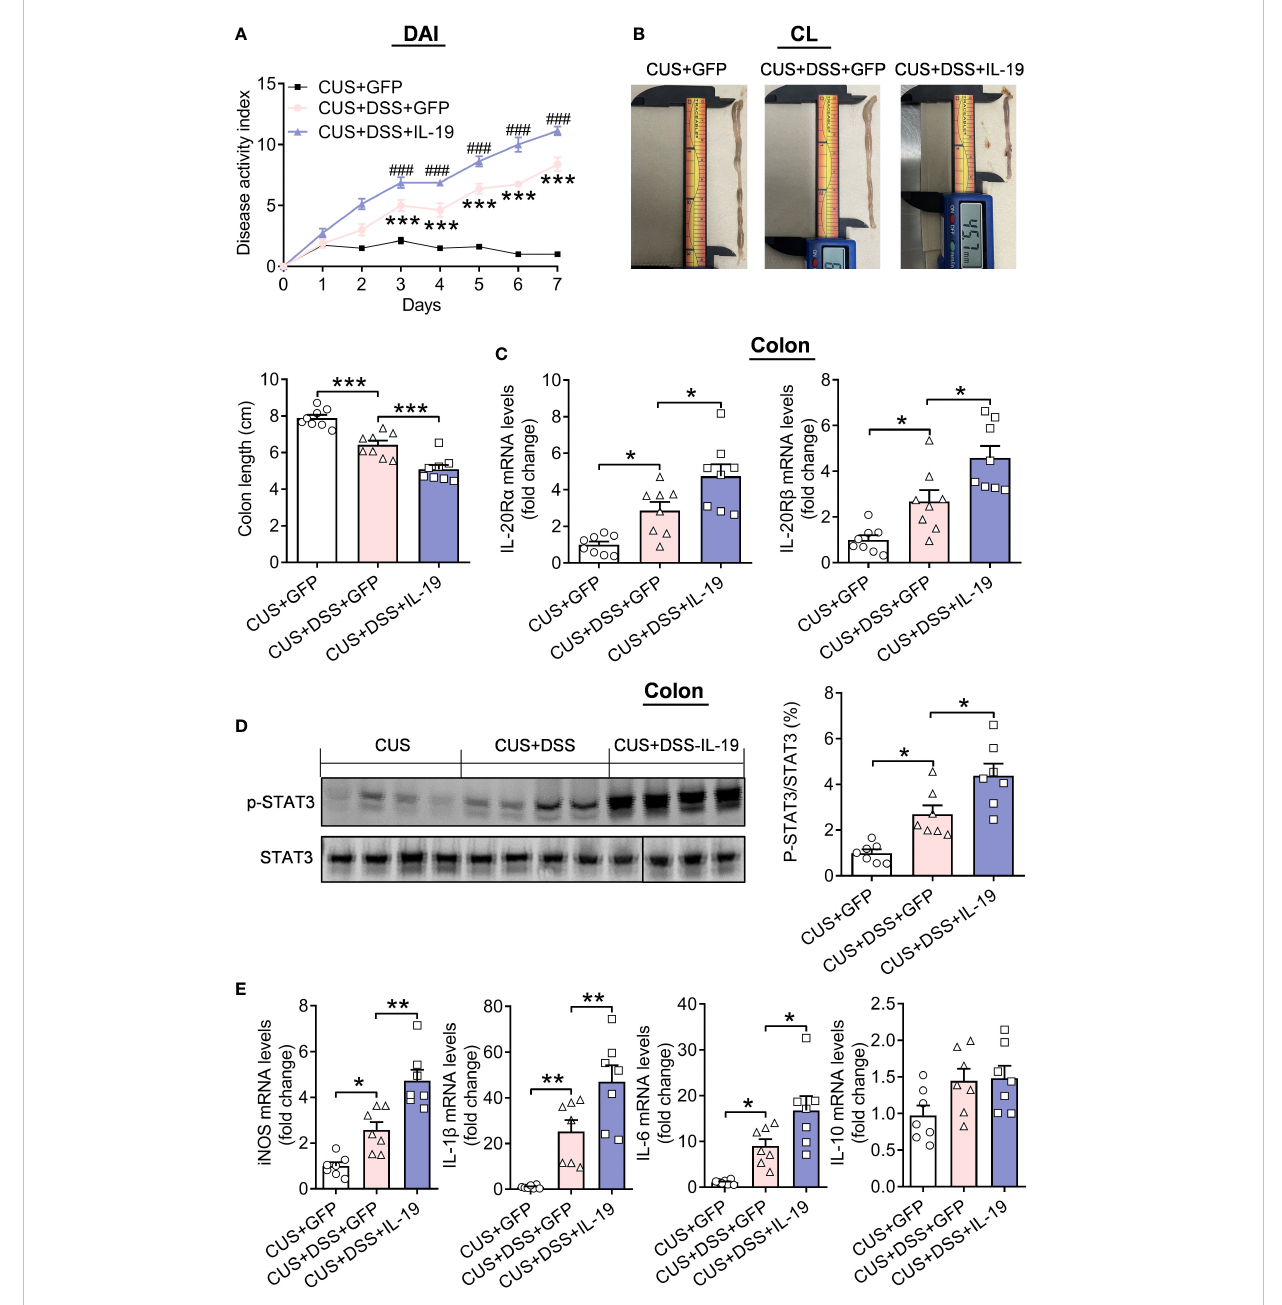
FIGURE 7 The effect of colonic IL-19 overexpression in the colitis in the DSS/CUS treated mice. (A) Disease Activity Index (DAI). (B) Colonic length (CL). (C) IL- 20Ra and IL-20Rb mRNA levels in the colon. (D) p-STAT3 levels in the colon. CUS + GFP group: n=8, CUS+DSS+GFP group: n=8, CUS+DSS+IL-19 group: n=8. (E) The mRNA levels of iNOS, IL-1 b , IL-6, and IL-10 in the colon. CUS + GFP group: n=7, CUS+DSS+GFP group: n=7, CUS+DSS+IL-19 group: n=7. * p < 0.05, ** p < 0.01, *** p < 0.001, **** p < 0.001, compared to the control